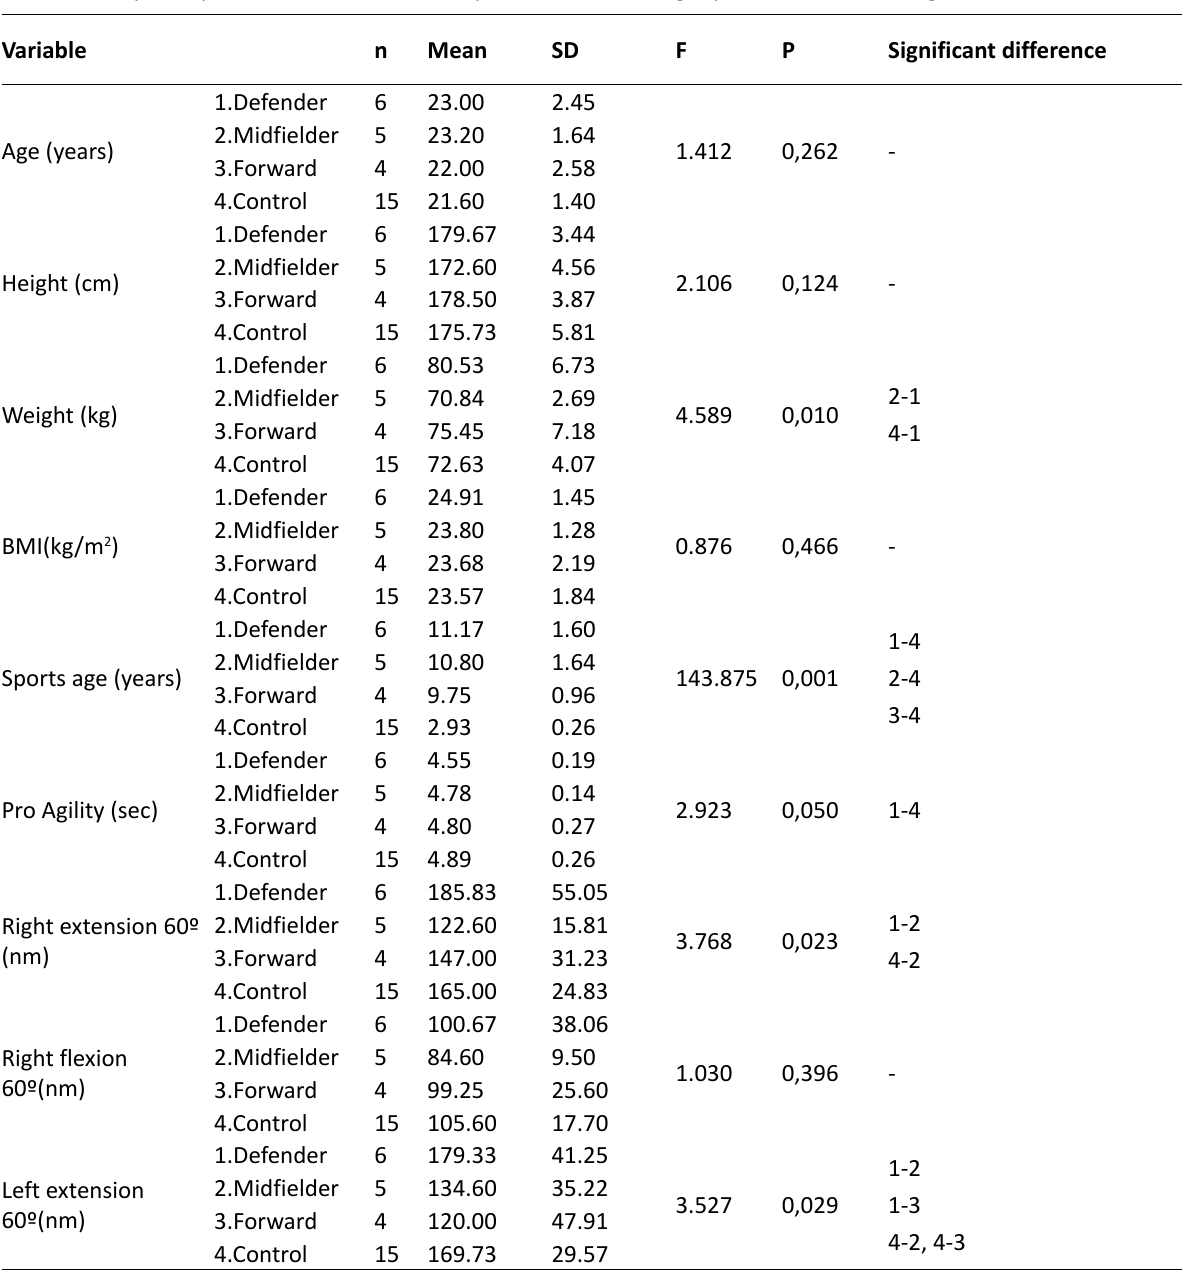
Table 5. Analysis of positions in terms of descriptive information, agility and isokinetic strength rates